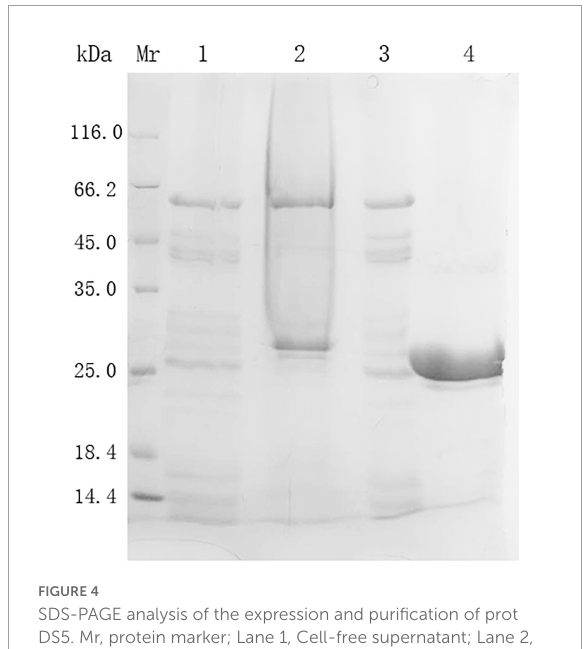
FIGURE4 SDS-PAGE analysis of the expression and purification of prot DS5. Mr, protein marker; Lane 1, Cell-free supernatant; Lane 2, 70% (NH4) 2 SO 4 precipitation sample; Lane 3, Sephadex G-25 desalted sample; Lane 4, sample after Superdex-75 gel chromatography.